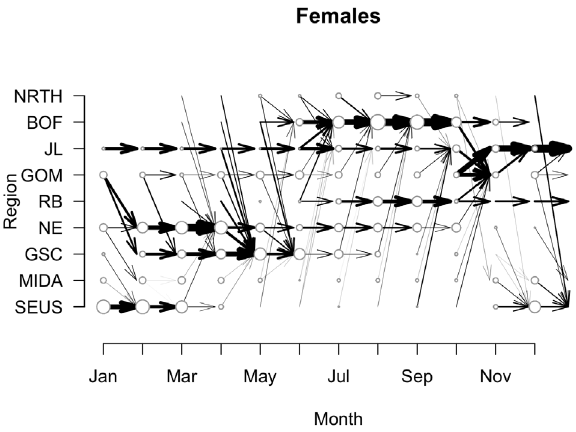
Figure 6. Movement transitions for female right whales. Posterior estimates of transitions made by female right whales between regions over the course of the year. Lines and circles as in Figure 5. In contrast to males, females spend more time in BOF, and have more estimated transitions to SEUS at the end of the year.